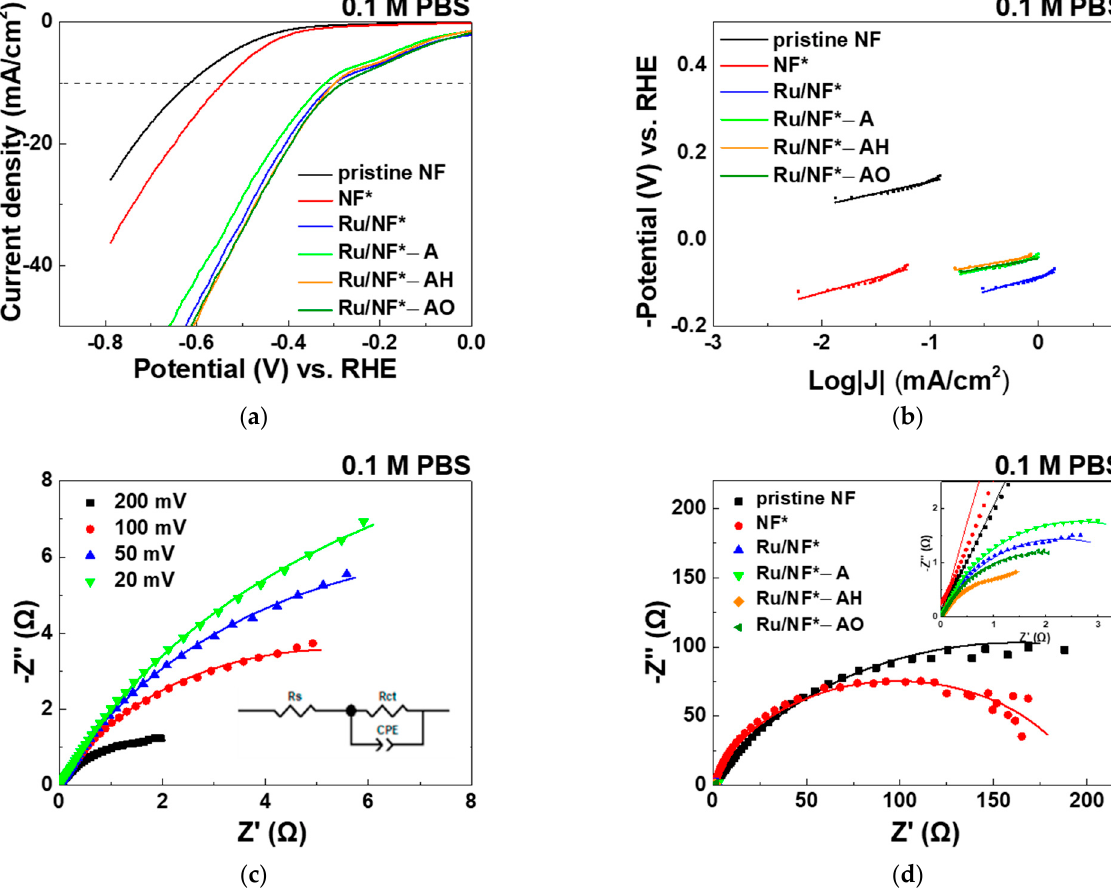
Figure 6. In 0.1 M PBS aqueous solution: ( a ) LSV polarization curves of pristine NF, NF*, Ru/NF*, Ru/NF*-A, Ru/NF*-AH, and Ru/NF*-AO toward HER. ( b ) Corresponding Tafel plots of HER. ( c ) Nyquist plots of the Ru/NF*-AO catalyst at four different applied overpotentials versus RHE. ( d ) Nyquist plots of pristine NF, NF*, Ru/NF*, Ru/NF*-A, Ru/NF*-AH, and Ru/NF*-AO catalysts at an overpotential of 200 mV versus RHE. Table 3. Corresponding parameters of electrocatalysts in 0.1 M PBS as calculated from Figure 6.